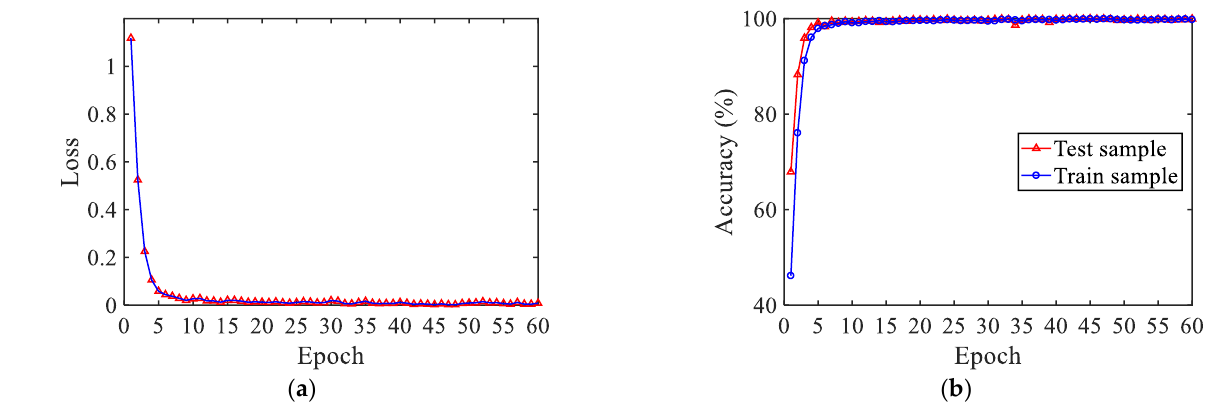
Figure 14. Tendency of loss and accuracy. ( a ) Loss , ( b ) accuracy .